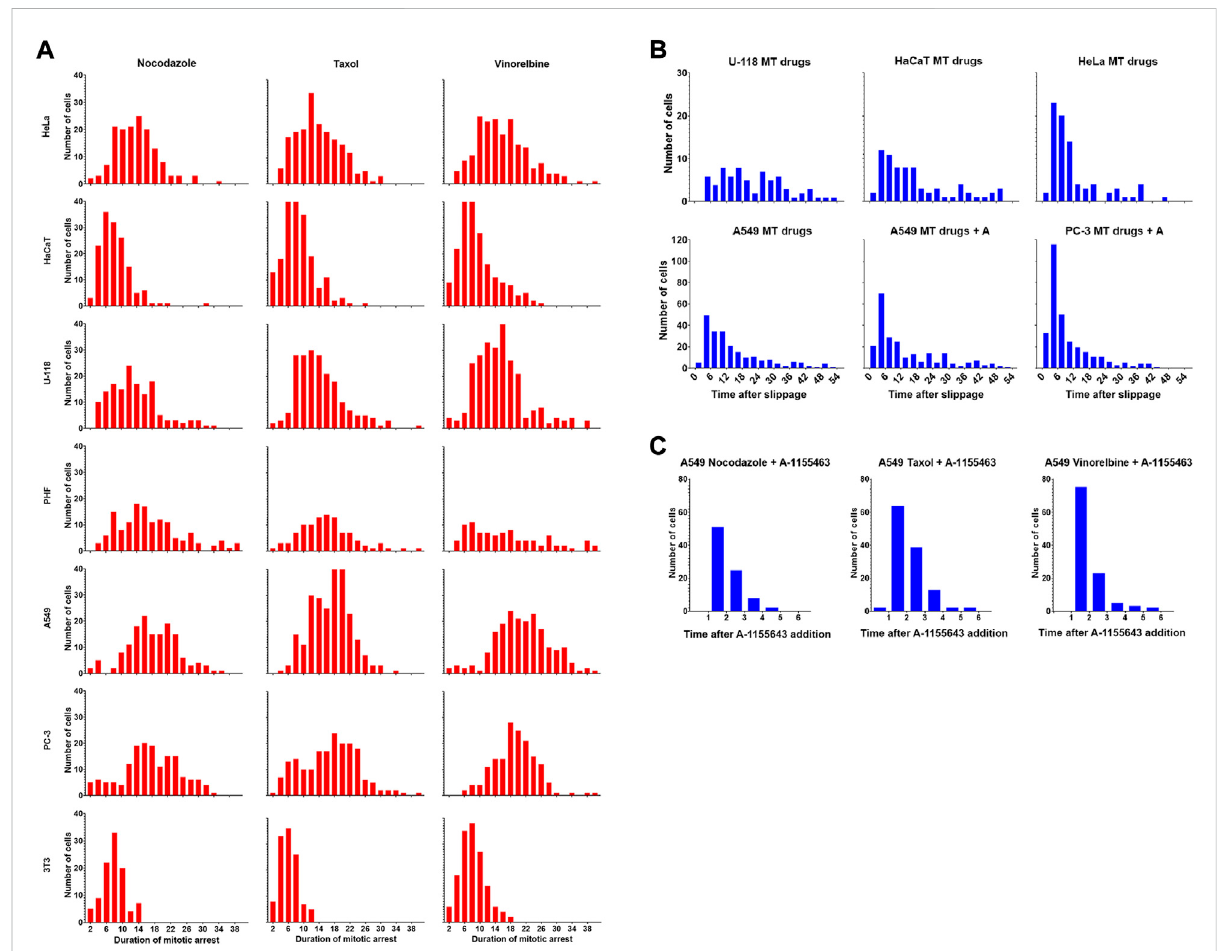
FIGURE 5 (A) Drug-dependent frequency distributions of the duration of mitotic arrest for seven cell lines. Time is shown in hours (B) . Frequency distributions of the duration of post-slippage interphase for the cells that died after mitotic slippage. Data is shown for U-118, HaCaT, HeLa, and A549 cells lines (MT drugs) and for sensitized A549 and PC-3 (MT drugs + A1155463). Data for each cell line are accumulated for three drugs. Time is shown in hours (C) . Frequency distributions of the duration of post-slippage interphase for A549 cells that died after mitotic slippage after sequential treatment with MT drugs and